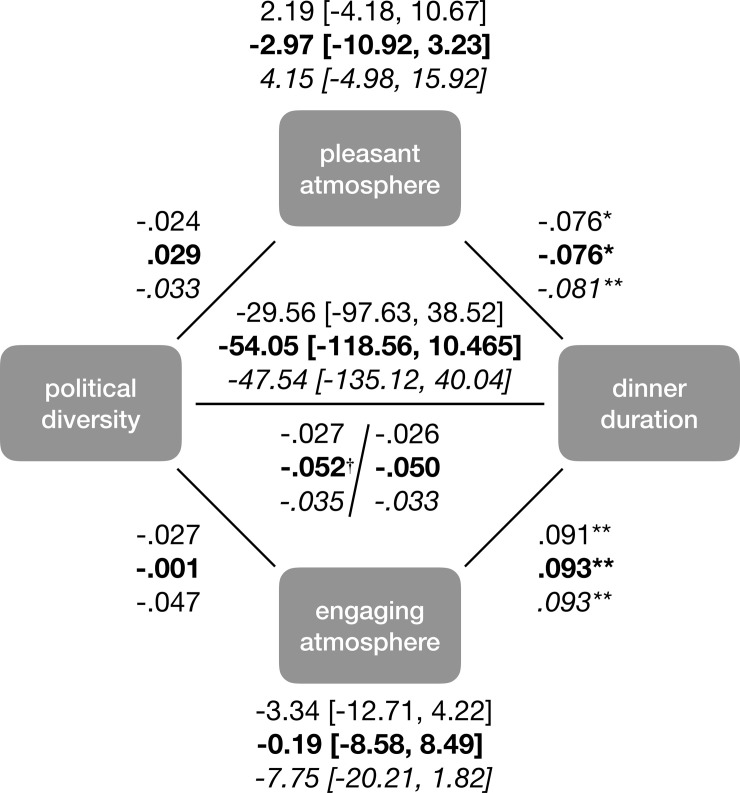
Mediation model assessing whether an unpleasant and/or engaging social atmosphere helped explain why political diversity might not be associated with shorter Thanksgiving dinners.Numbers in plain text represent diversity defined in terms of attitudes toward Trump. Numbers in boldface represent diversity defined in terms of attitudes toward impeachment. Numbers in italics represent diversity defined in terms of party affiliation. † p < .10, * p < .05, ** p < .01.